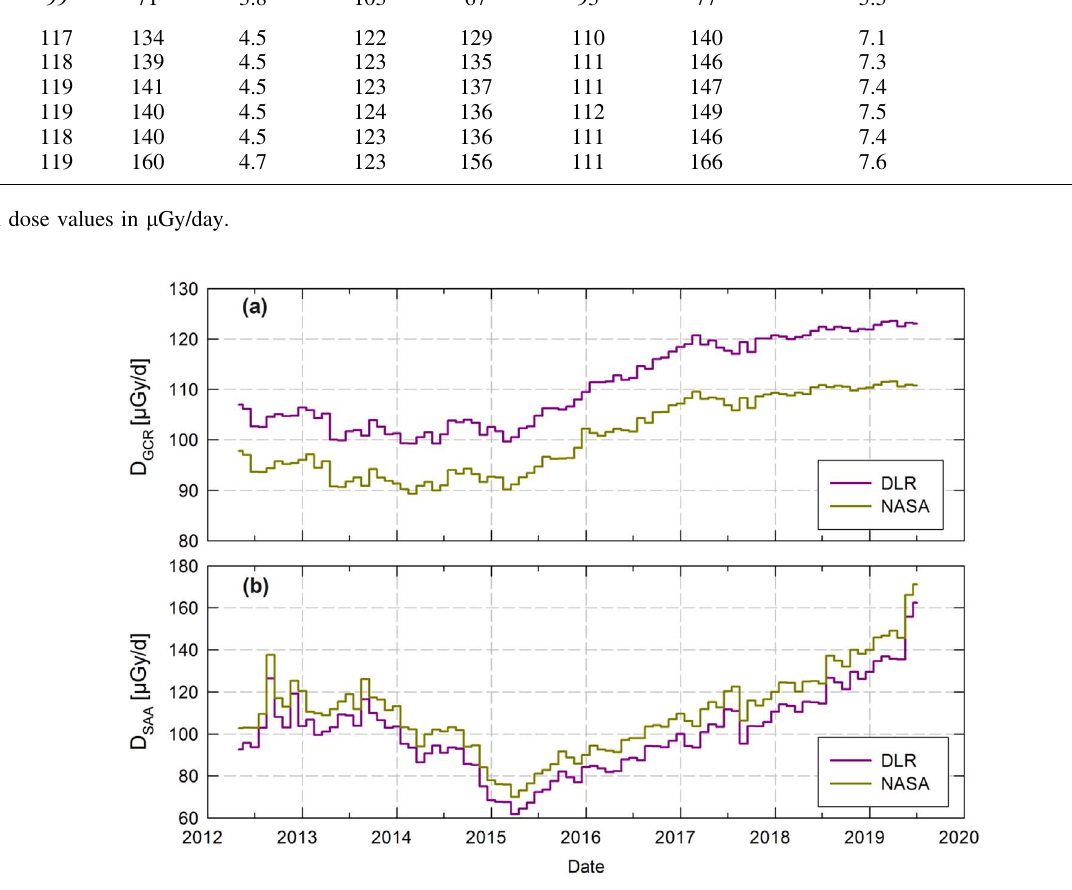
Fig. 6. (a) Daily GCR dose for DLR (dark pink) and NASA (dark yellow) procedure and (b) daily SAA dose for DLR (dark pink) and NASA (dark yellow) procedure.